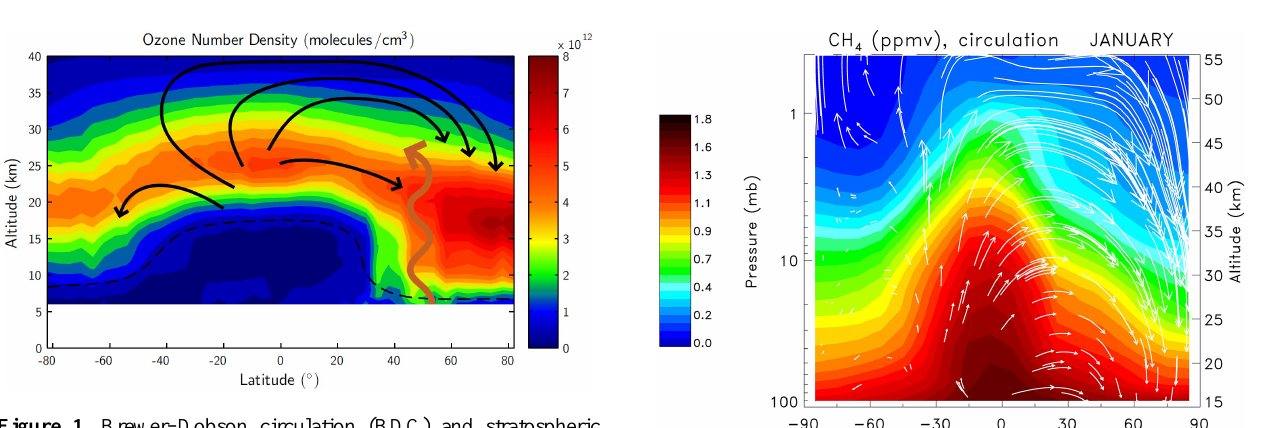
Figure 1. Brewer–Dobson circulation (BDC) and stratospheric ozone. The sense of this net circulation or BDC is shown by the black arrows overlain on the zonally averaged ozone distribution (or its number density in molecules per cm 3 versus latitude and al- titude) for March 2004, as measured by the OSIRIS satellite instru- ment. Wiggly orange arrow indicates the propagation of waves from the troposphere as they affect the ozone. The dashed black line is the tropopause (adaption of figure in Shaw and Shepherd, 2008).